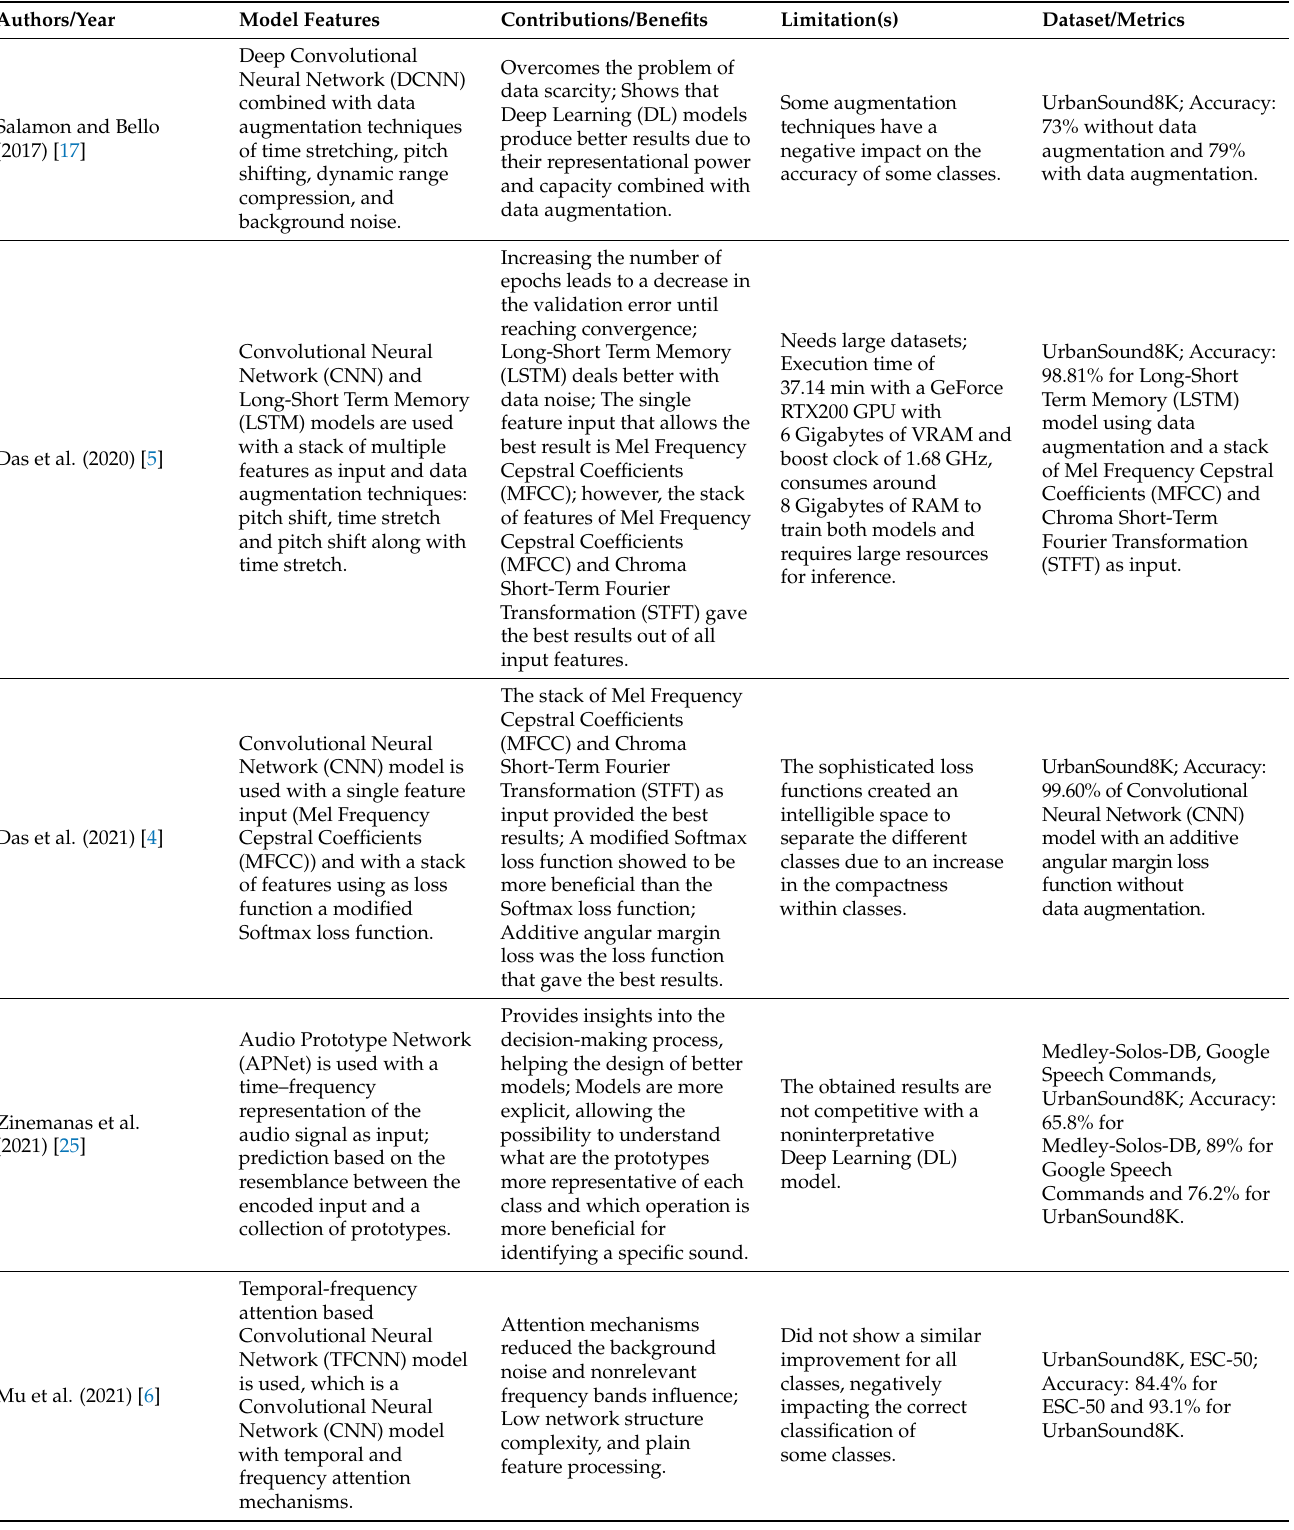
Table 1. Resume of the research articles found on audio classification using Neural